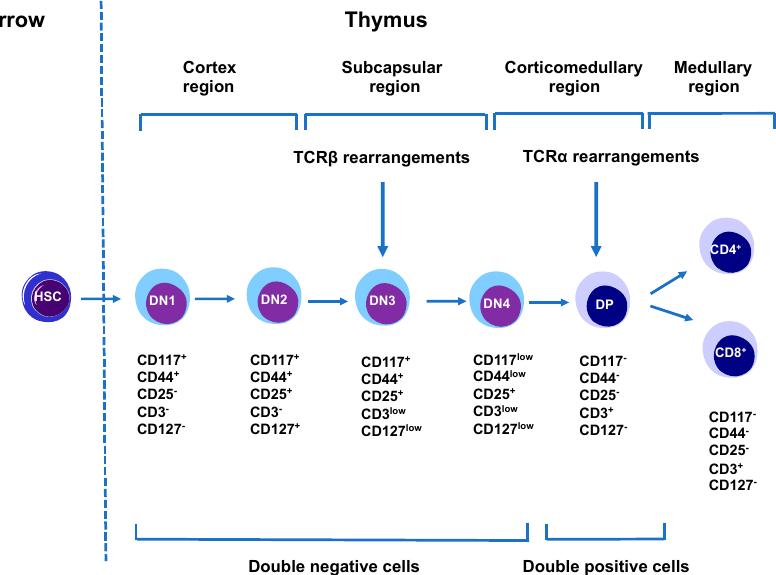
Figure 3. T cell development and maturation. T cells originate from hematopoietic stem cells in the bone marrow. These cells then migrate to thymus where they first develop into double-negative thymocytes (DN1-DN4). These thymocytes can be differentiated based on CD117, CD44, CD25, CD3, and CD 127 markers. DN4 then differentiates into double-positive (DP, CD4 + CD8 + ) thymocytes after pre-TCR signaling. These DP’s differentiate into single-positive thymocytes as CD4 + and CD8 + cells.